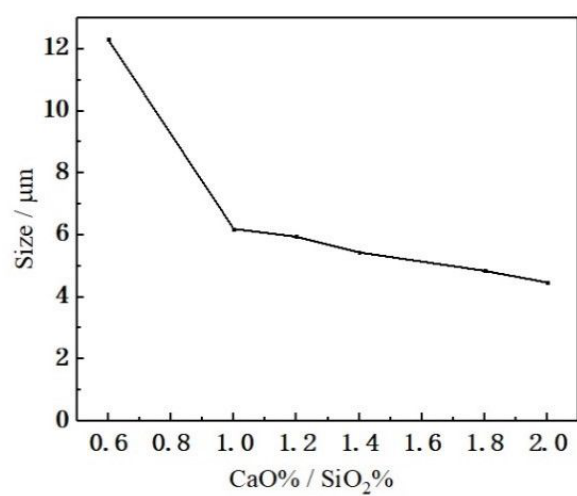
Figure 6: Effect of basicity on the size of spinel crystals.